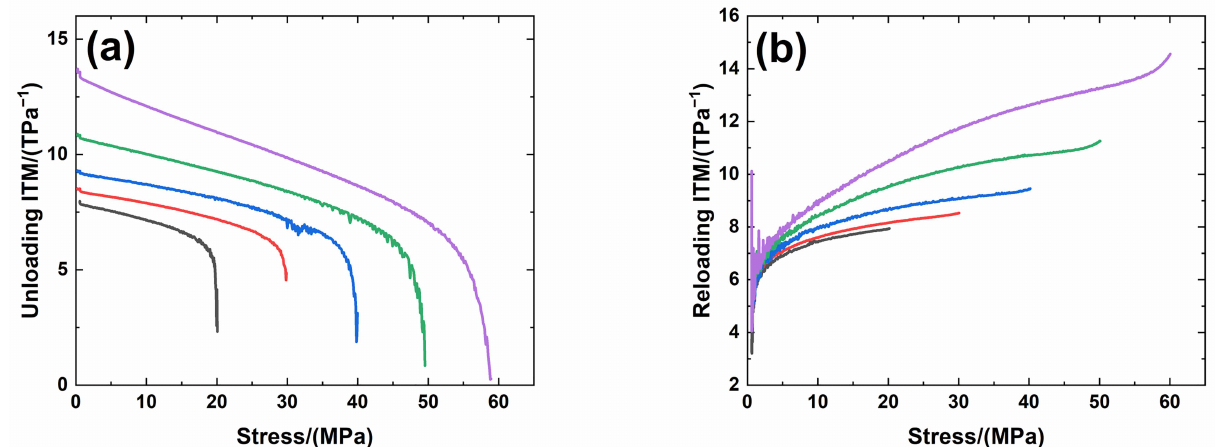
Figure 9. ( a ) Unloading ITM; and ( b ) reloading ITM of Type 2 3D needle-punched C/SiC composite. For Type 1 3D needle-punched C/SiC composite, the tensile properties are listed